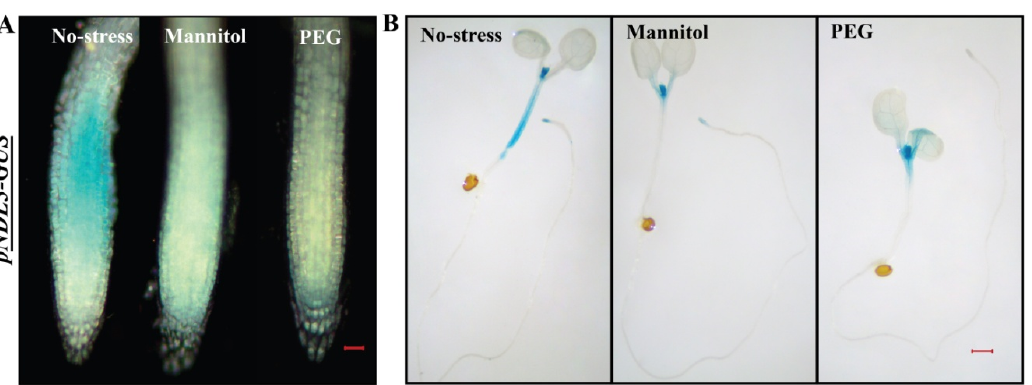
Figure 6. In vivo histochemical analysis of GUS activity for NDL2 in wild type Col-0 background in response to different abiotic stresses and hormones: Histochemical GUS staining of 6-D-old transgenic Arabidopsis seedlings ( pNDL2-GUS) in wild type Col-0 background. Increased intensity levels of GUS staining detected with ABA, cold, and JA. Result shown is representative of three independent biological replicates ( n ≥ 10 in each experiment). Scale Bar = 0.2 μM.